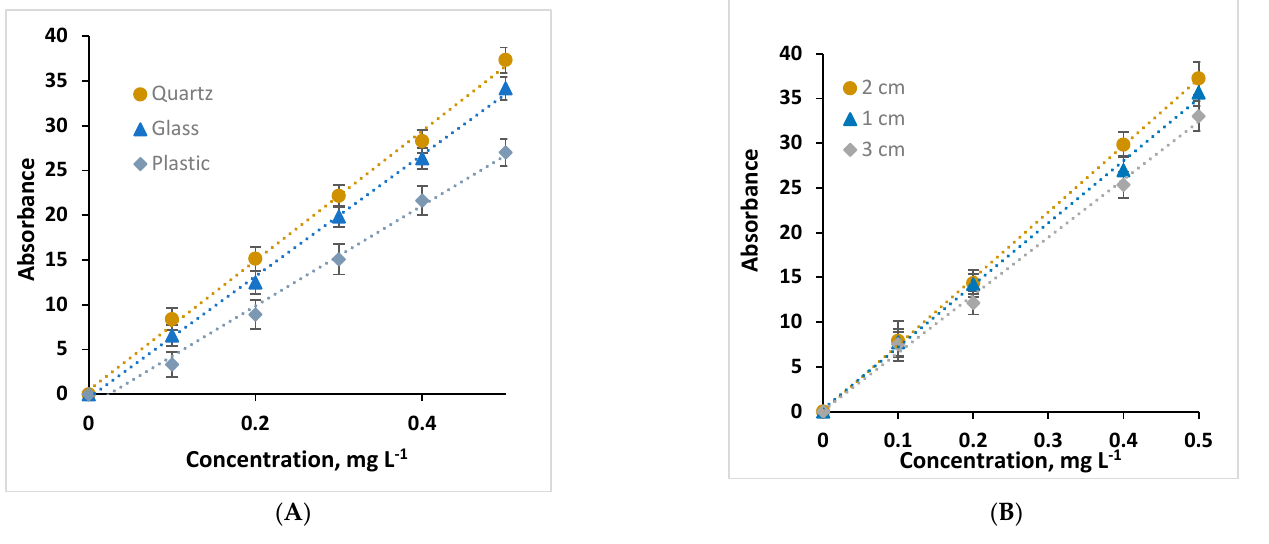
Figure 1. ( A ) Analysis of the type of cuvette to be used, ( B ) Influence of the webcam distance from the cuvette. Working conditions: 0–0.5 mg L − 1 quinine sulphate diluted in 0.05 M acid sulfuric.